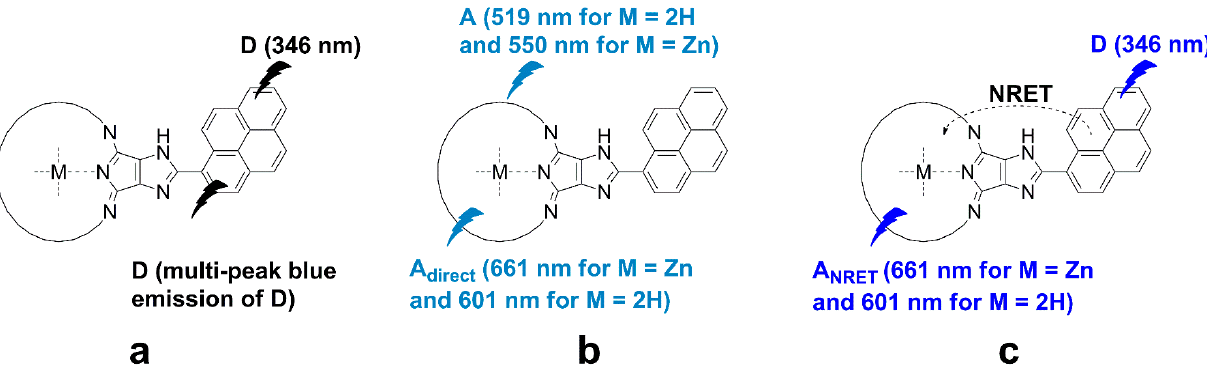
Figure 3. The schematic of the photophysical processes occurring in the studied dyads upon photoexcitation: ( a ) excitation of pyrenyl fragment and measurement of its proper emission, denoted D-D ; ( b ) excitation of the porphyrin and measurement of its proper emission, denoted A-A direct , and ( c ) excitation of the pyrenyl fragment and measurement of porphyrin core emission, denoted D-A NRET .